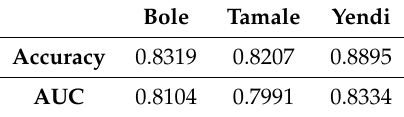
Table 1. Performance of evaluation metrics of the proposed stacking ensemble classification.